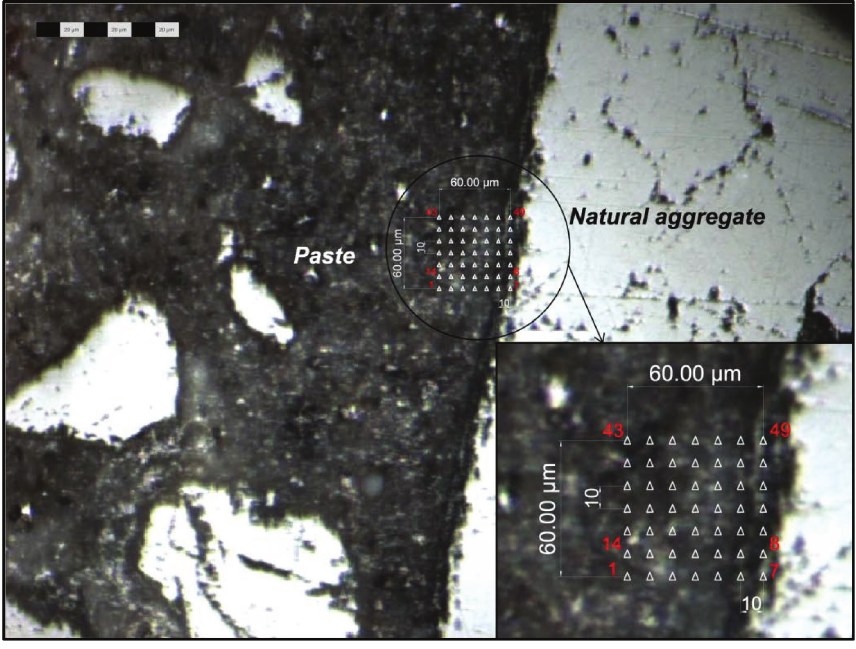
Fig. 3. BSE image of natural aggregate interfacial transition zone, where the dimension of the indented area is 60×60 μm with an indent spacing of 10